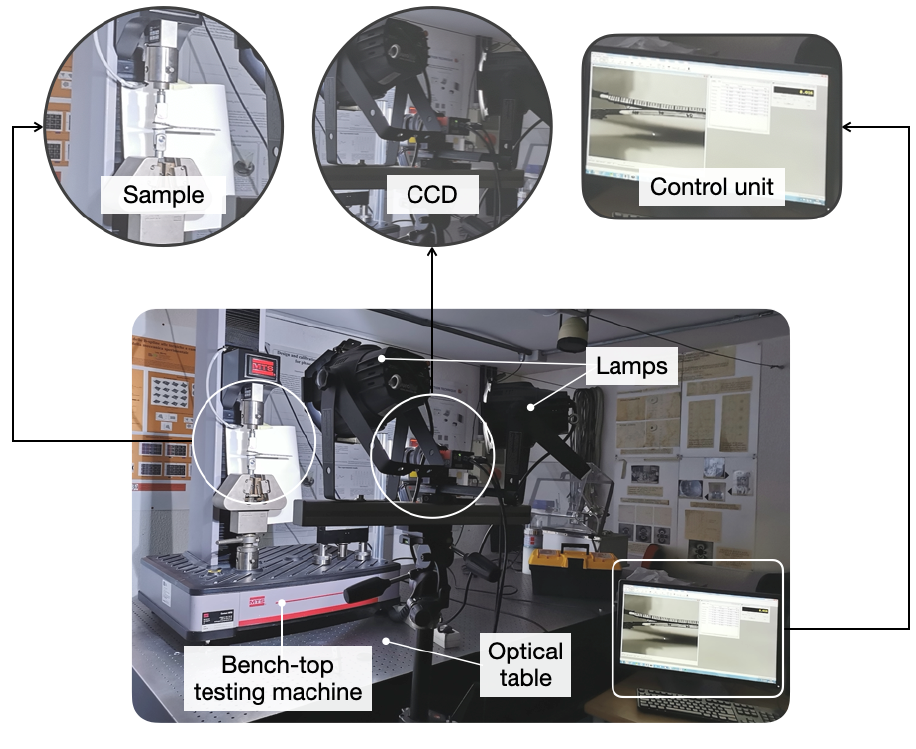
Figure 2. Experimental setup employed in mechanical testing of double cantilever beam (DCB) adhesive